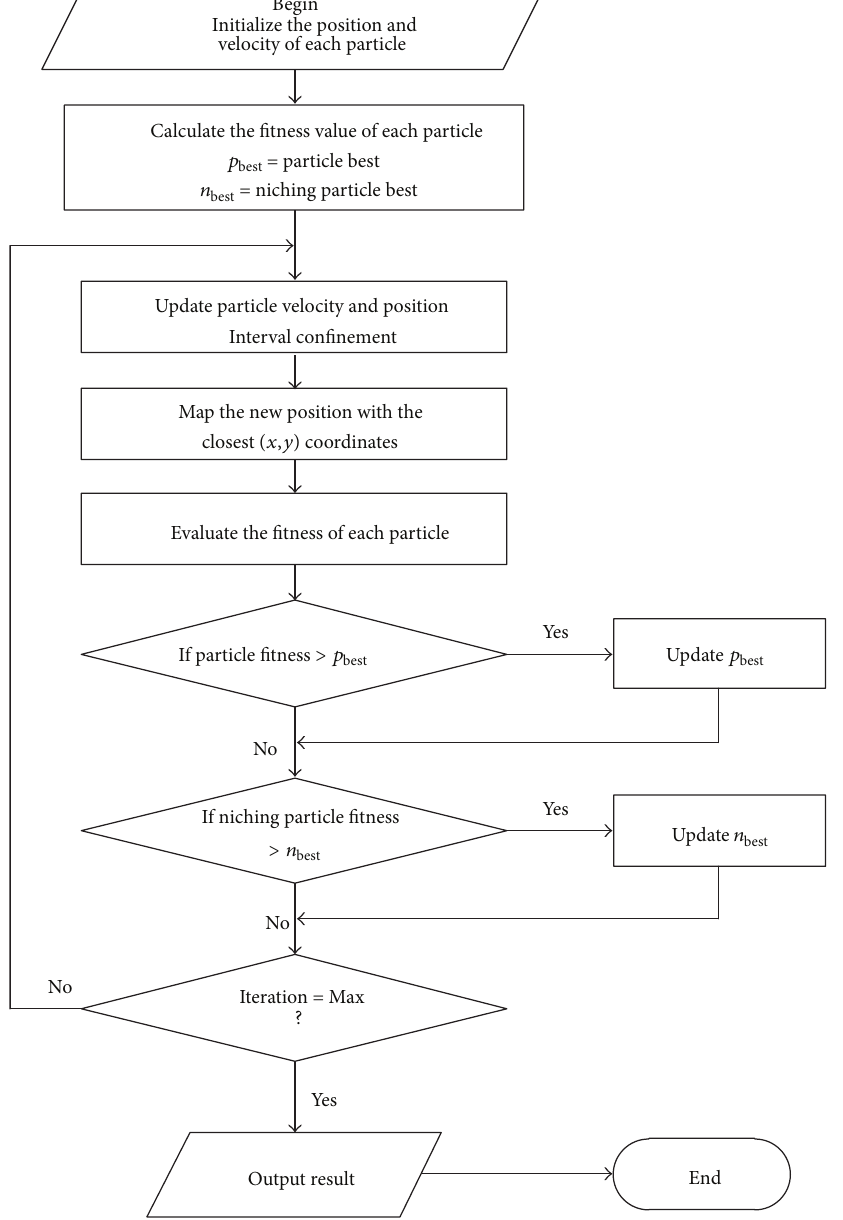
Figure 2: The flowchart of the DCH-NPSO protocol for cluster